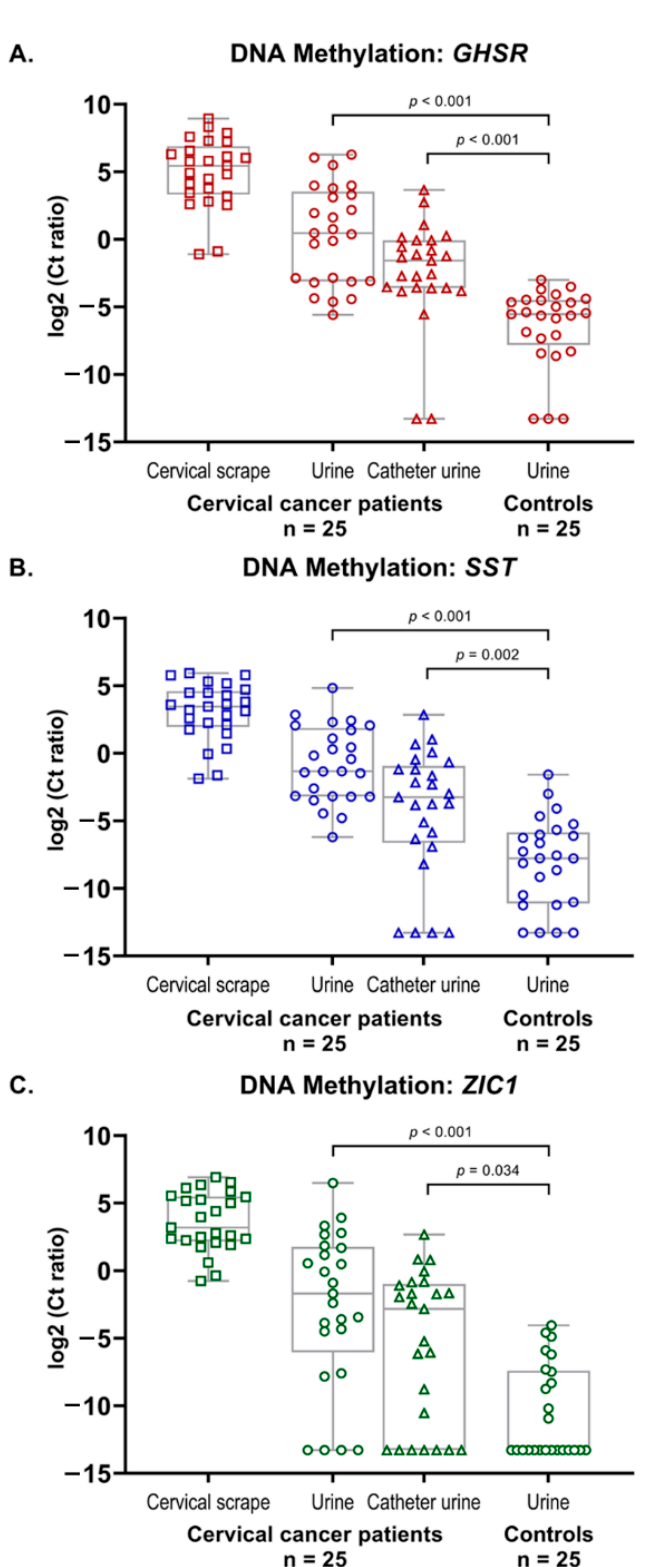
Figure 2. DNA methylation levels of markers GHSR ( A ), SST ( B ), and ZIC1 ( C ) in paired cervical scrapes, natural voided urine, and catheter urine from 25 cervical cancer patients, as well as in natural voided urine from 25 healthy female controls. DNA methylation levels are represented by the log2-transformed Ct ratios. Boxplots show medians with the 25th and 75th percentile and whiskers range from the smallest to the largest value.